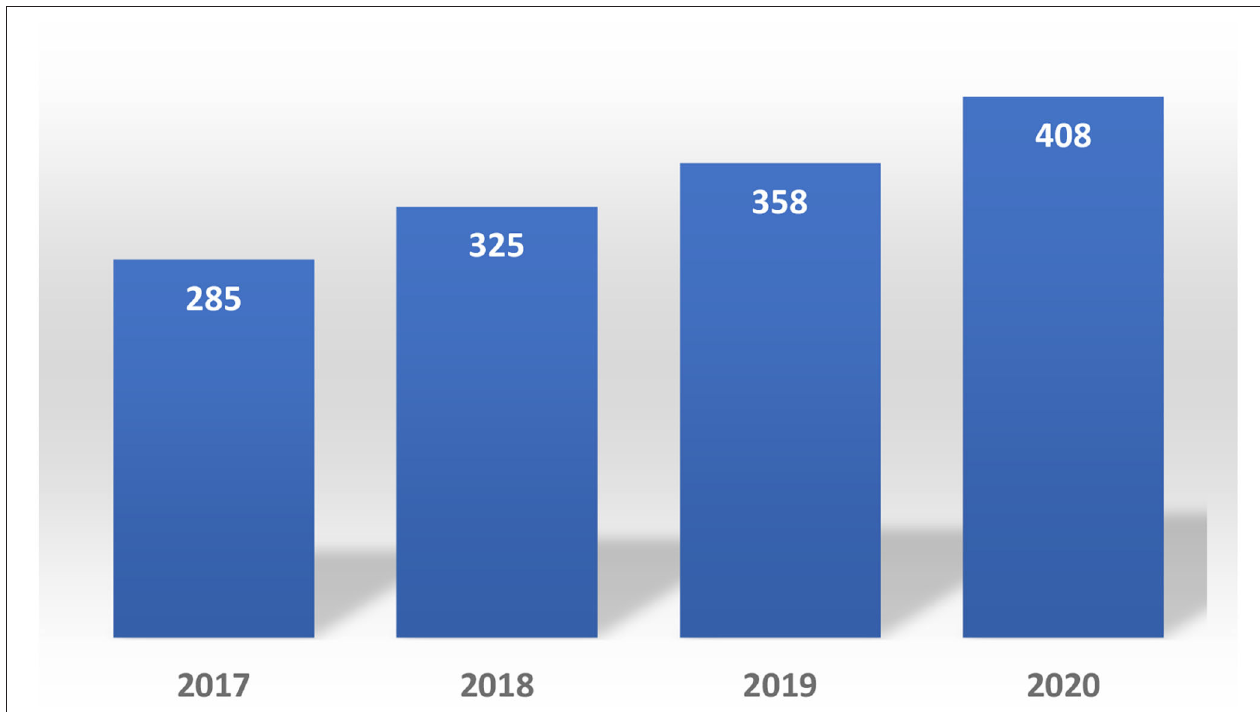
FIGURE 7 | Post-approval changes submitted in Costa Rica (2017–2020)